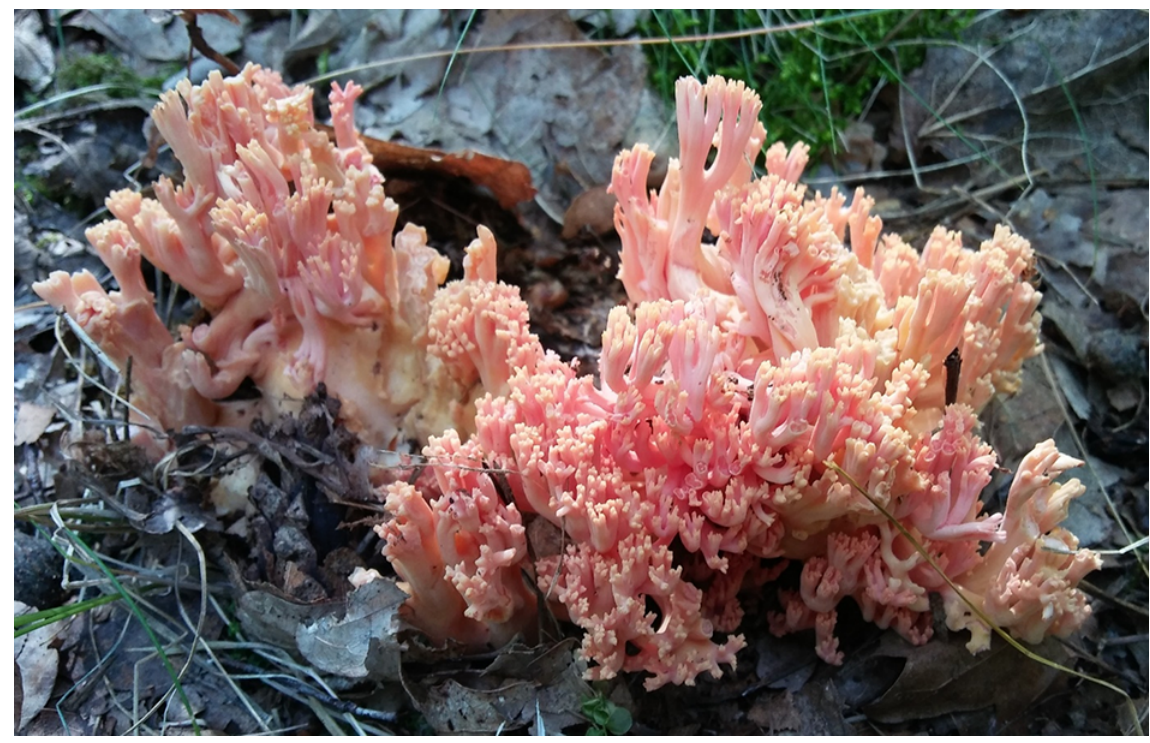
Figure 3 Basidiomata of Ramaria subbotrytis from the Kampinos National Park; September 19, 2020. Photography by A.